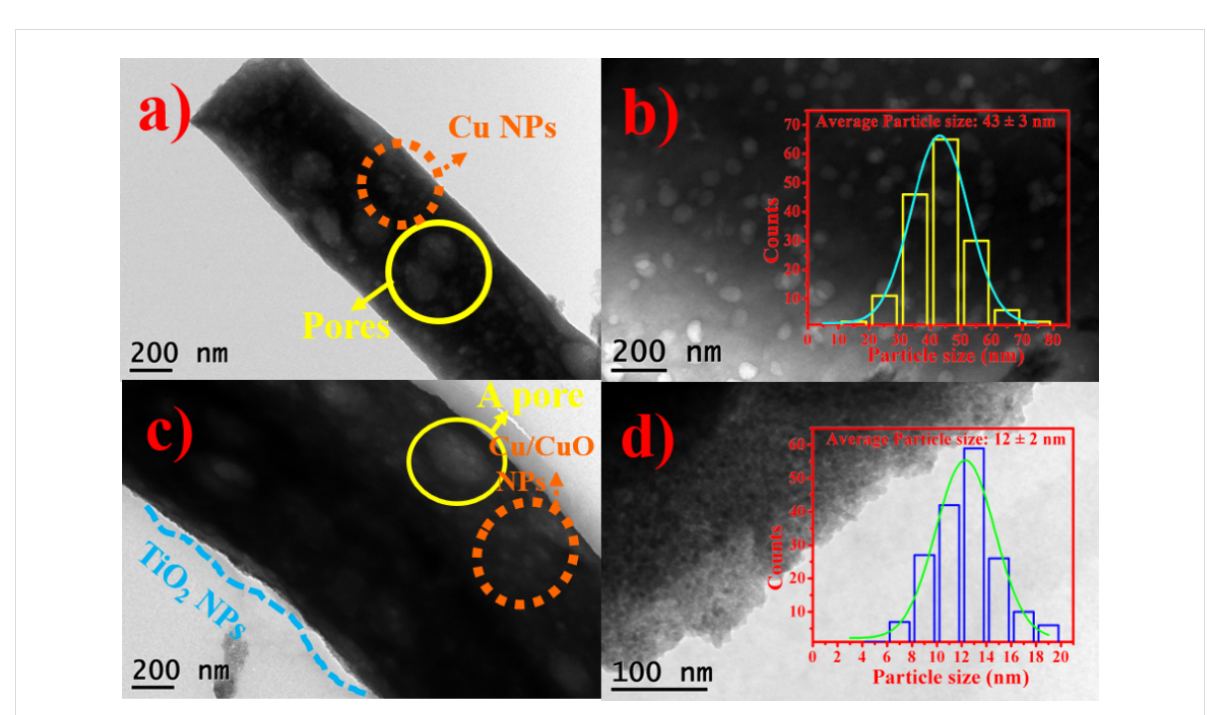
Figure 6: TEM image of (a) Cu/PCNF and (c) Cu/CuO/PCNF/TiO 2 composites and (b, d) corresponding magnified images of (a, c). Inset (b, d) parti- cle size distribution of Cu and TiO 2 , respectively.